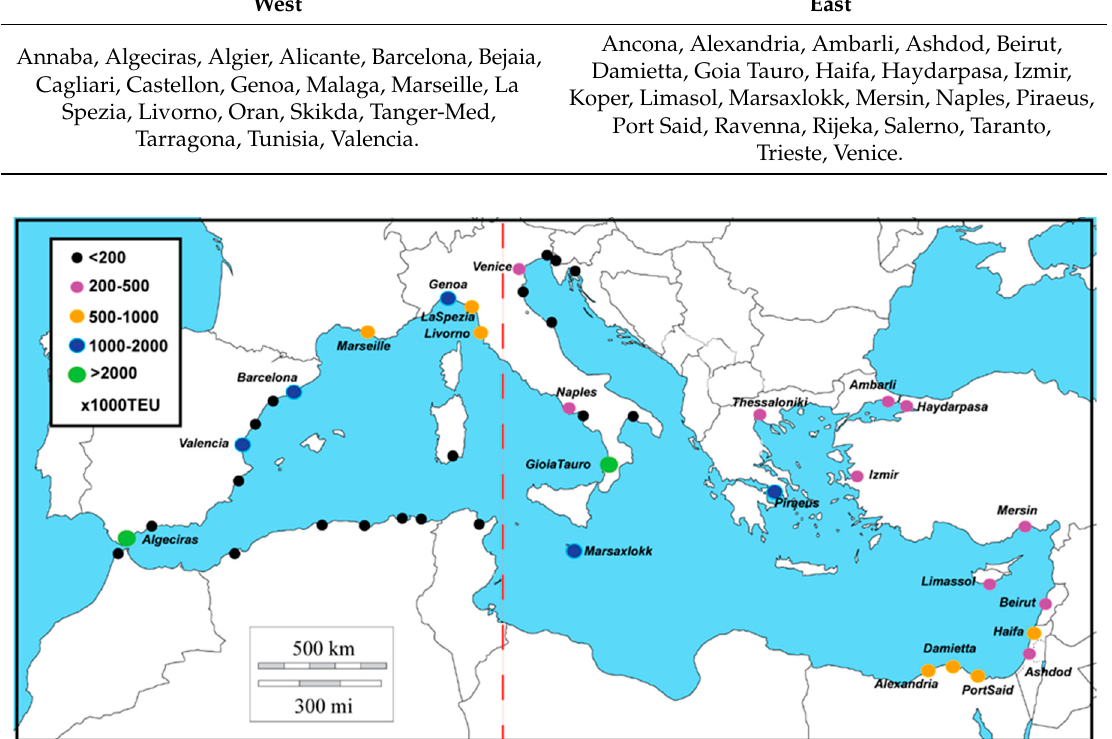
Table 1. Ports considered in each one of the two regions defined for the analysis. West East